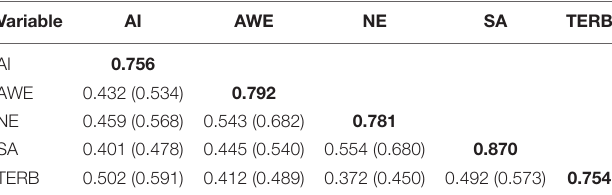
TABLE 3 | Correlation matrix of all